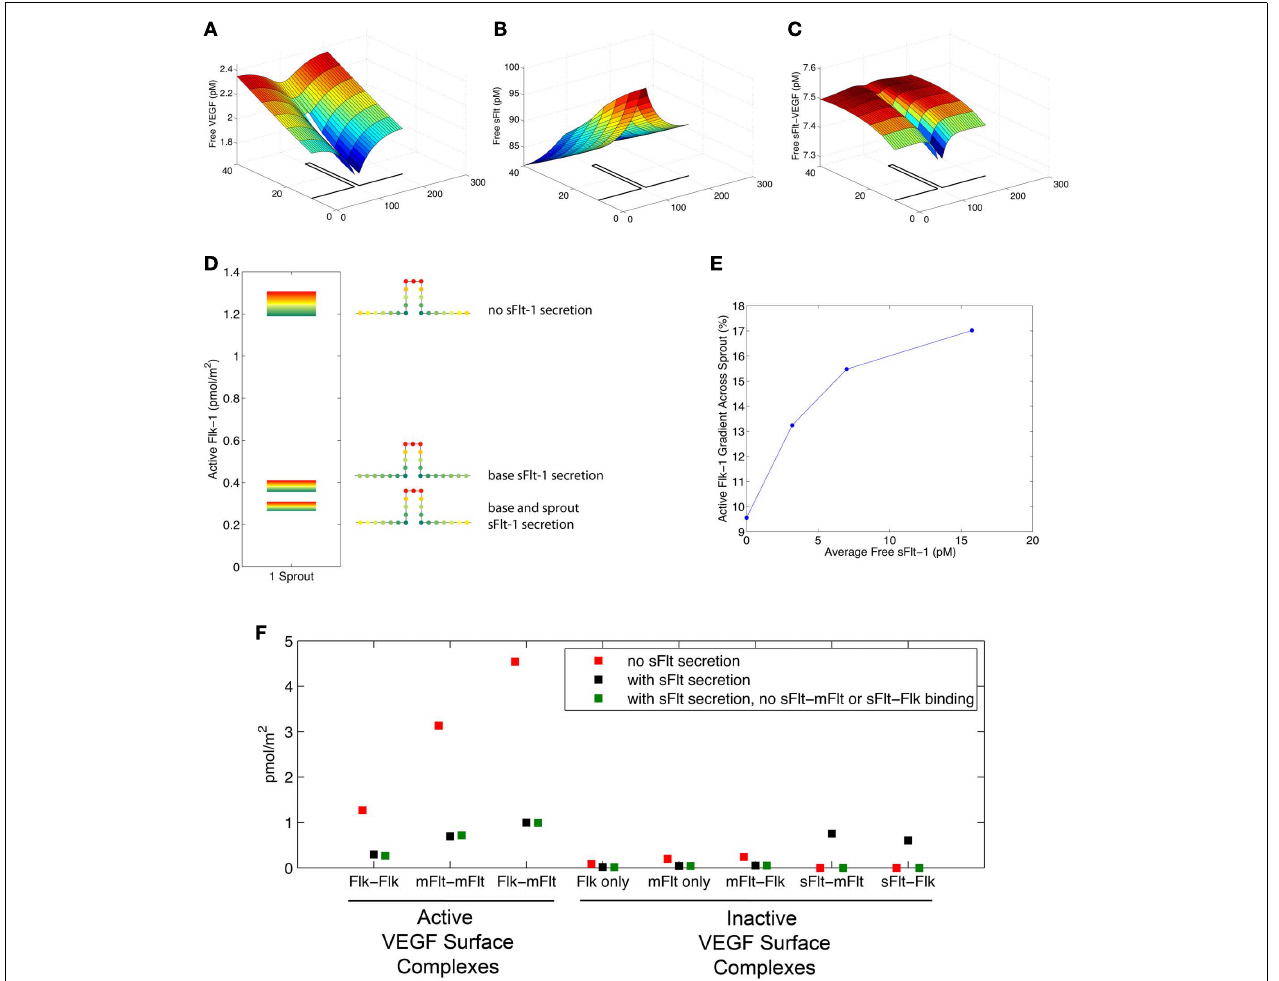
and sprout. sFlt-1 secretion decreases the absolute amount and relative gradient of Flk-1 activation on the surface of sprouts. (E) As free sFlt-1 increases (due to increased sFlt-1 secretion) so does relative Flk-1 activation along the sprout. (F) Average receptor complex concentrations along the sprout for three cases: no sFlt-1 secretion (red), base and sprout sFlt-1 secretion (black), and base and sprout sFlt-1 secretion without any sFlt-1 binding to surface receptors mFlt-1 or Flk-1 (green). ActiveVEGF surface complexes are shown on the left, and inactive surface complexes are on the right.The removal of sFlt-1 heterodimerization barely affects activeVEGF surface receptor complex levels.